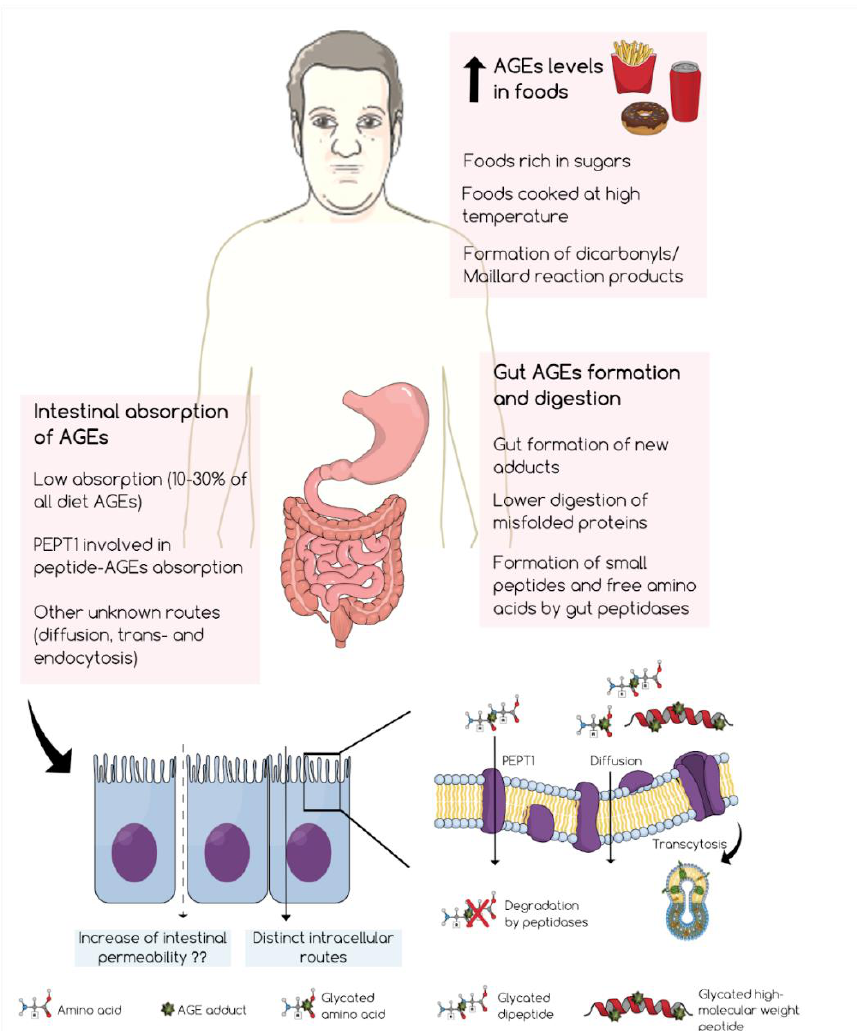
Figure 1. Overview of the events involved in glycotoxin consumption from sugar-rich foods, their digestion in the gastrointestinal tract, and their intestinal absorption. The lower part of the image shows the different mechanisms described to be involved in intestinal AGE